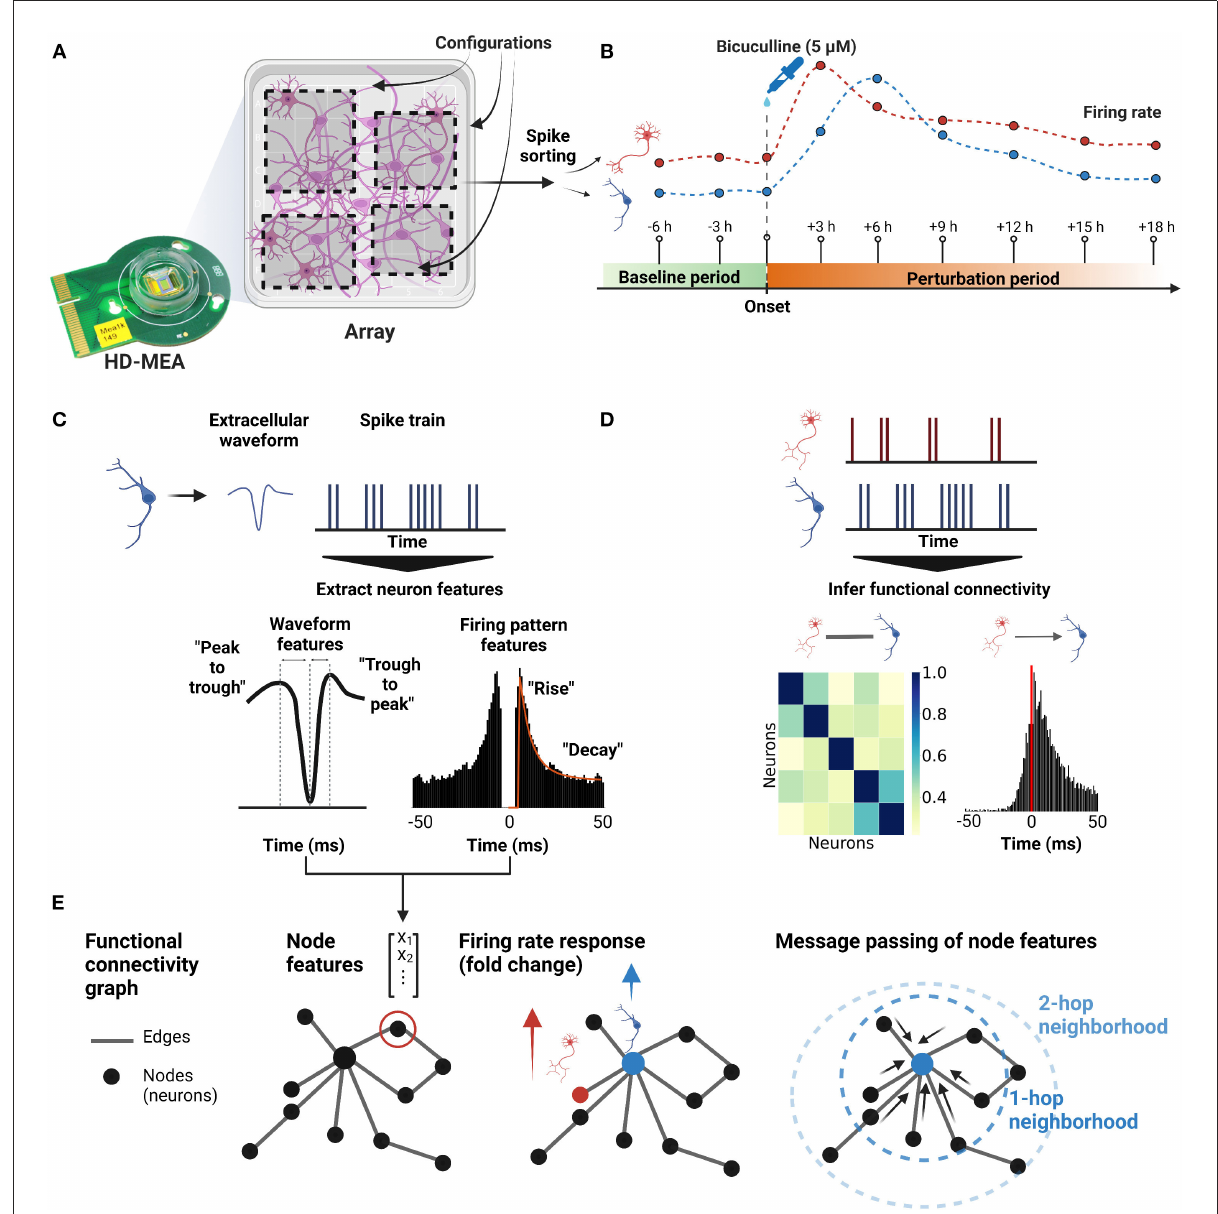
FIGURE1 Overview of the experiment. (A) Dissociated primary neurons from rat hippocampi were cultured on HD-MEAs until the neurons reached a mature state, i.e., days in vitro (DIV) 21. For each HD-MEA, four dense electrode configurations were defined to capture most of the network activity. (B) Using the same configurations, nine consecutive recordings were acquired with the first two recordings being the baseline recordings and the other seven recordings measuring the perturbation response (BIC, 5 µ M). For each configuration (sub-network), all nine recordings were concatenated and then spike-sorted to obtain extracellular waveforms and spike trains of the neurons. From the spike train of each neuron, the firing rate trajectory of each neuron throughout the perturbation window was reconstructed. (C) To characterize each neuron, four extracellular waveform features and three firing pattern features were extracted from the spike-sorted outputs. (D) Both, undirected and directed FCs were inferred between spike trains of neurons. (E) Connectivity graphs were constructed based on the FCs, and each neuron in the graph had seven single-neuron features obtained from step (C) as node features. GNN models were then used to predict firing rate changes of individual neurons using the node features and the inferred functional connectivity.